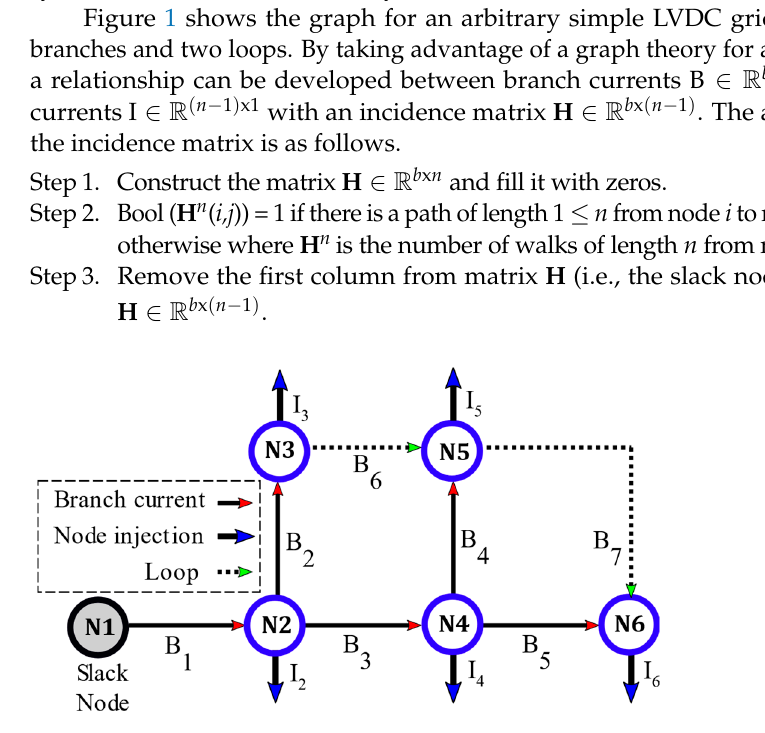
Figure 1. Graph of a simple low voltage direct current (LVDC) distribution system.